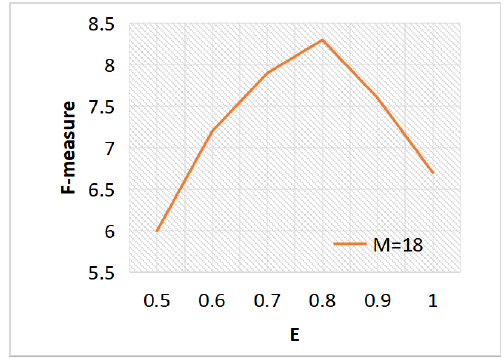
Figure 5. The impact of E .